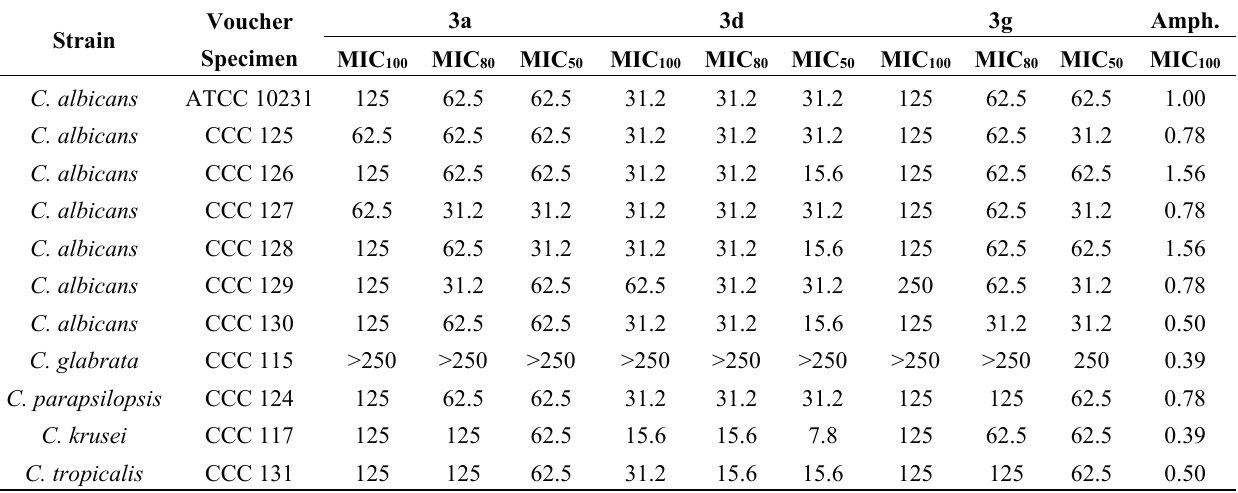
Table 5. The 100%, 80% and 50% inhibitory concentrations (MIC 100 , MIC 80 and MIC 50 ) of 3a , 3d , and 3g against clinical isolates of C. albicans and non-albicans Candida strains. For the sake of comparison, MIC 100 , MIC 80 and MIC 50 of all compounds against the ATCC 10231 standardized strain of C. albicans are